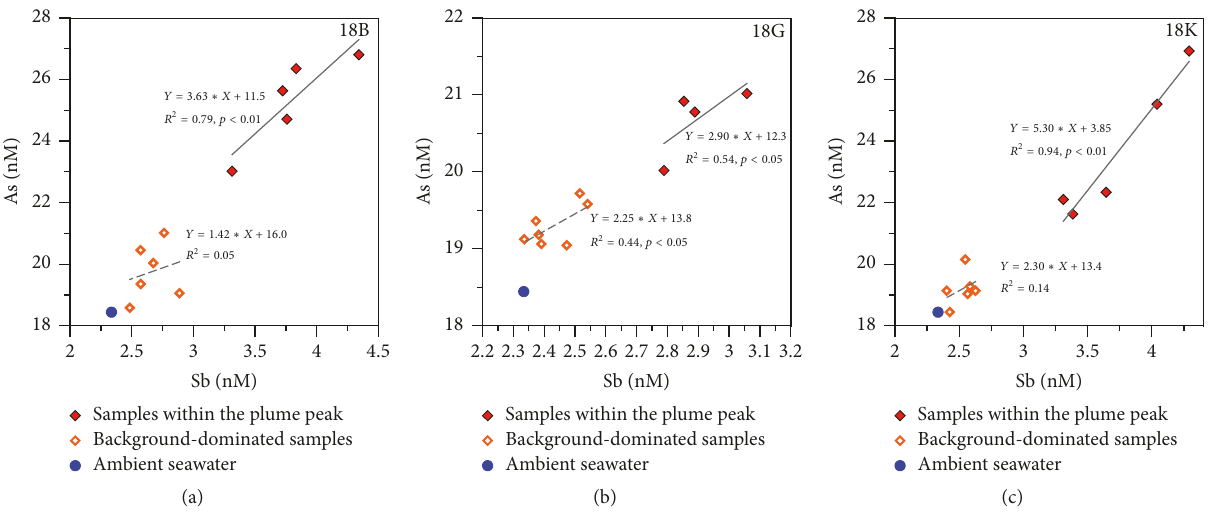
Figure 5: Correlations between As and Sb at (a) Station 18B, (b) Station 18G, and (c) Station 18K in the plume in the eastern Manus basin.